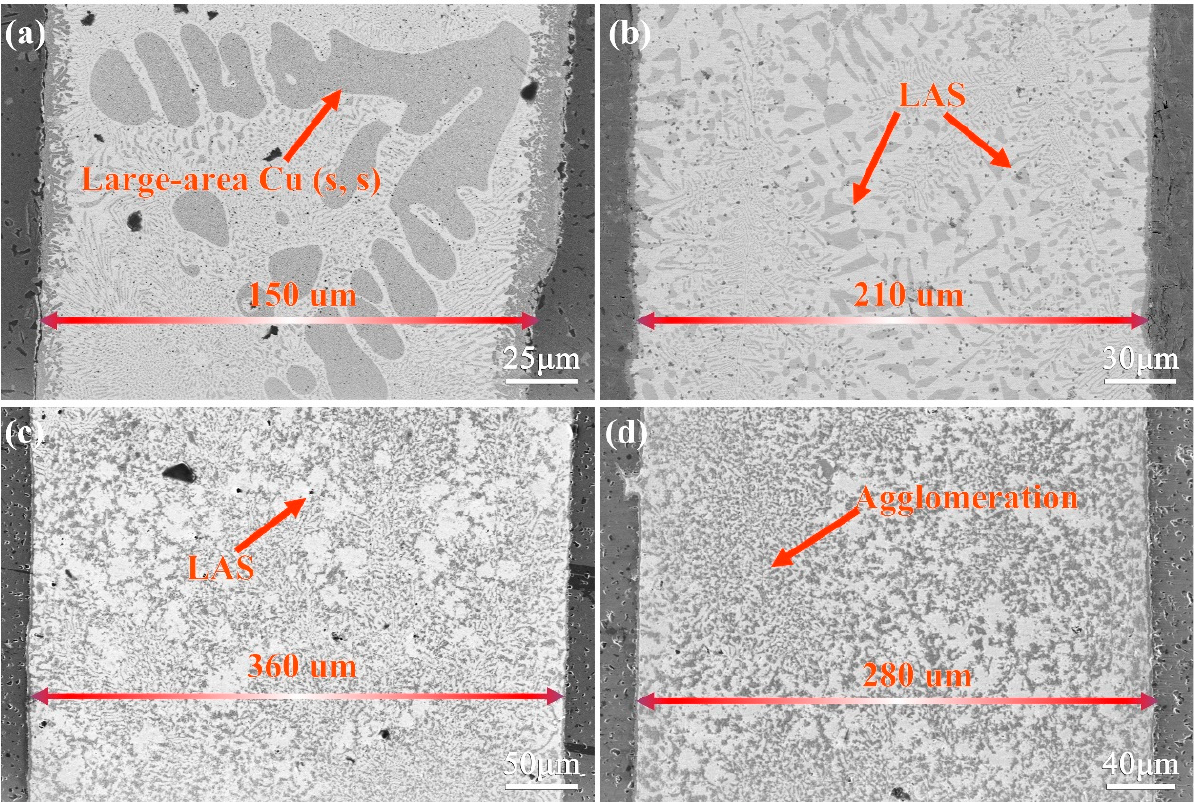
Figure 9. Typical interfaces of AgCuTi + 1 wt% LiAlSiO 4 brazed SiC joints with different holding times at 900 °C; ( a – d ) holding times 5 min, 10 min, 15 min, and 20 min, respectively.